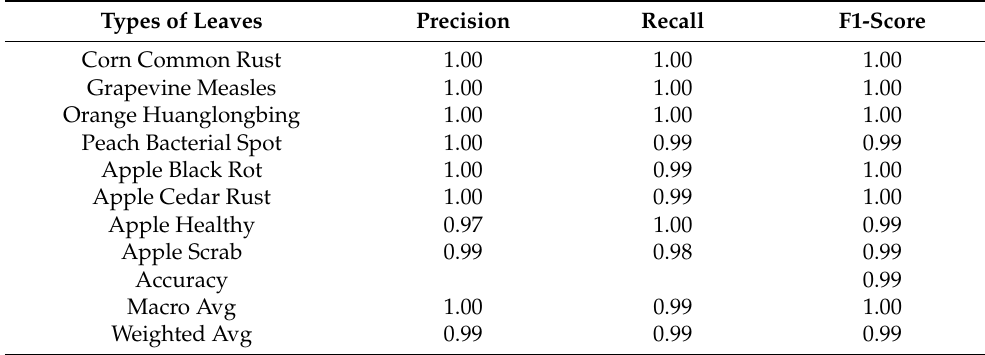
Table 3. Evaluation metrics scores of Top-8 leaves. Types of